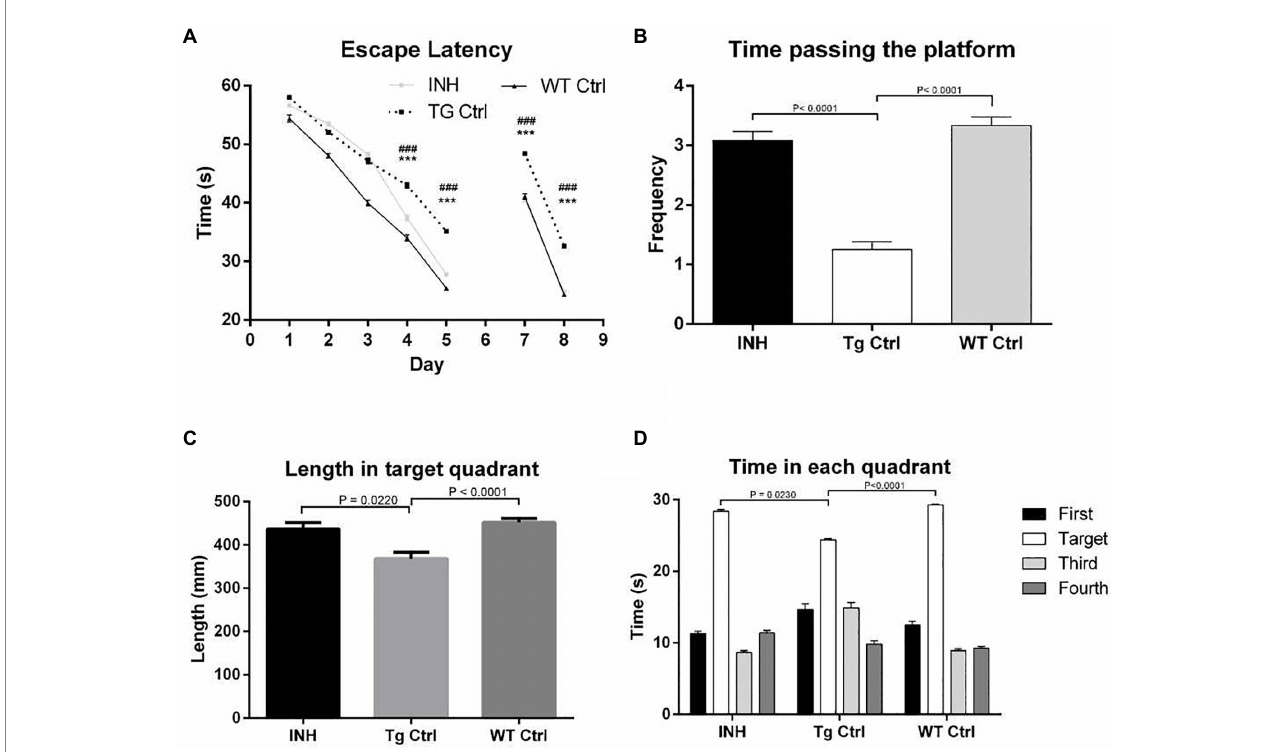
FIGURE 1 INH improved the spatial learning abilities of the APP/PS1 mice in the MWM. (A) Comparison of the escape latency time in the learning trail and the reversal test. In the probe trial, the times of platform crossing (B) , the path length at the target quadrant (C) , and the time spent in the target quadrant (D) were compared among the